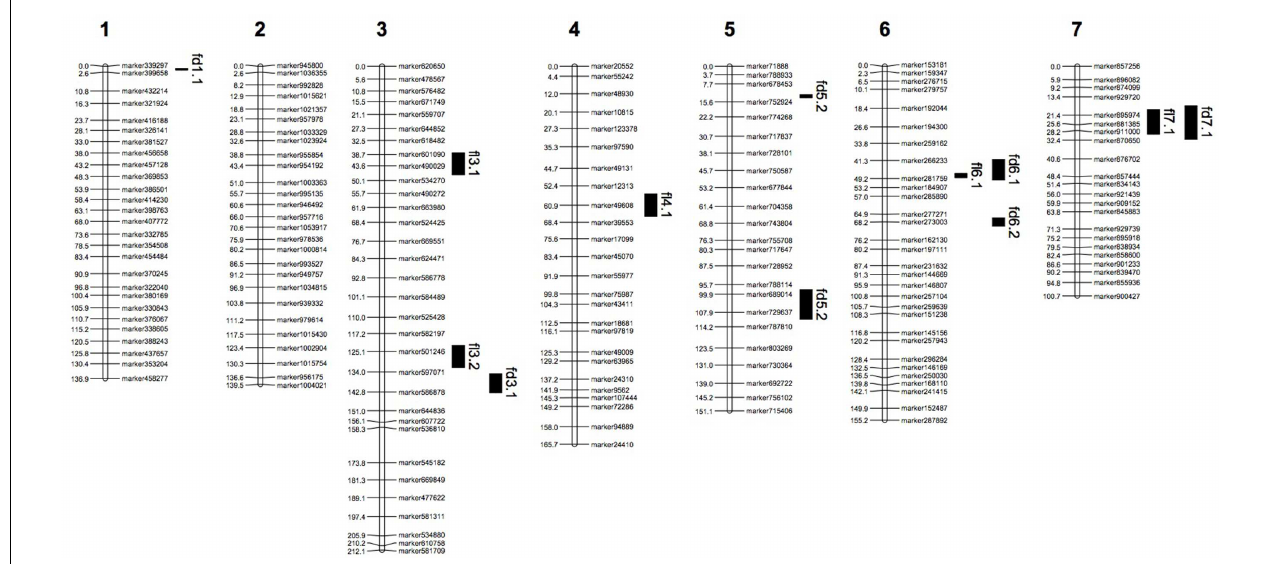
FIGURE 5 | Genetic linkage map with QTL locations on seven LGs. fd: QTLs of fruit length; fl: QTLs of fruit diameter.